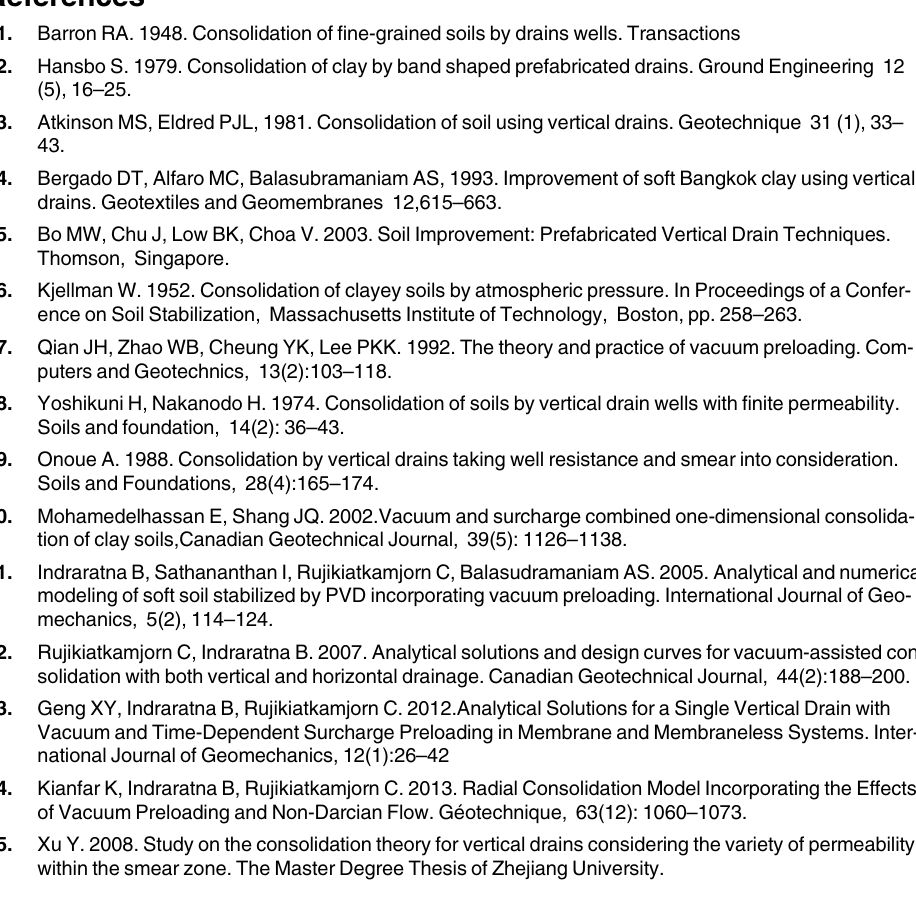
S3 Fig. Data of Fig 5(B). S4 Fig. Data of Fig 5(C). S5 Fig. Data of Fig